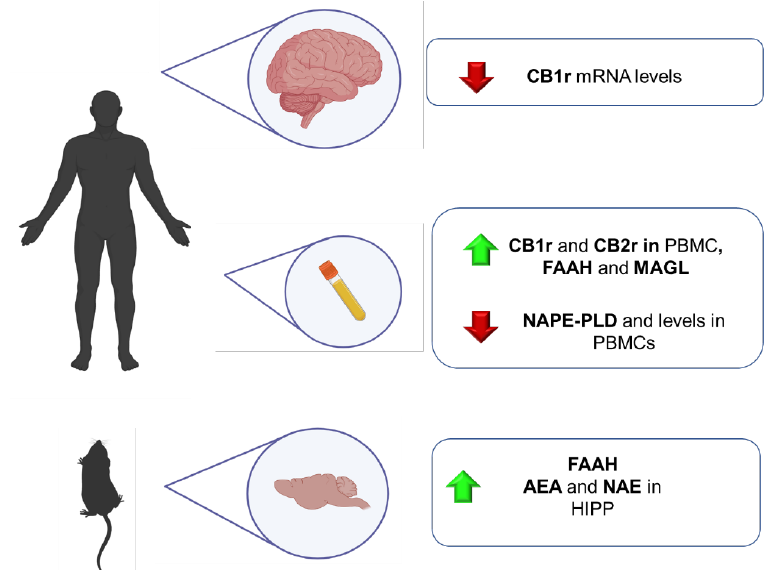
Figure 5. Main findings regarding the alterations of the ECS components in animal models and patients with autism spectrum disorders. AEA: anandamide; CB1r: cannabinoid receptor 1; CB2r: cannabinoid receptor 2; FAAH: fatty acid amide hydrolase; HIPP: hippocampus; NAPE-PLD: N-acyl phosphatidylethanolamine phospholipase, NAE: N- acetyl ethanolamine.